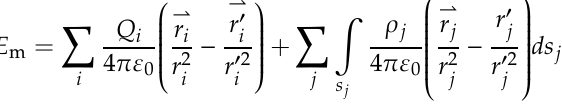
Figure 3. CSM method.